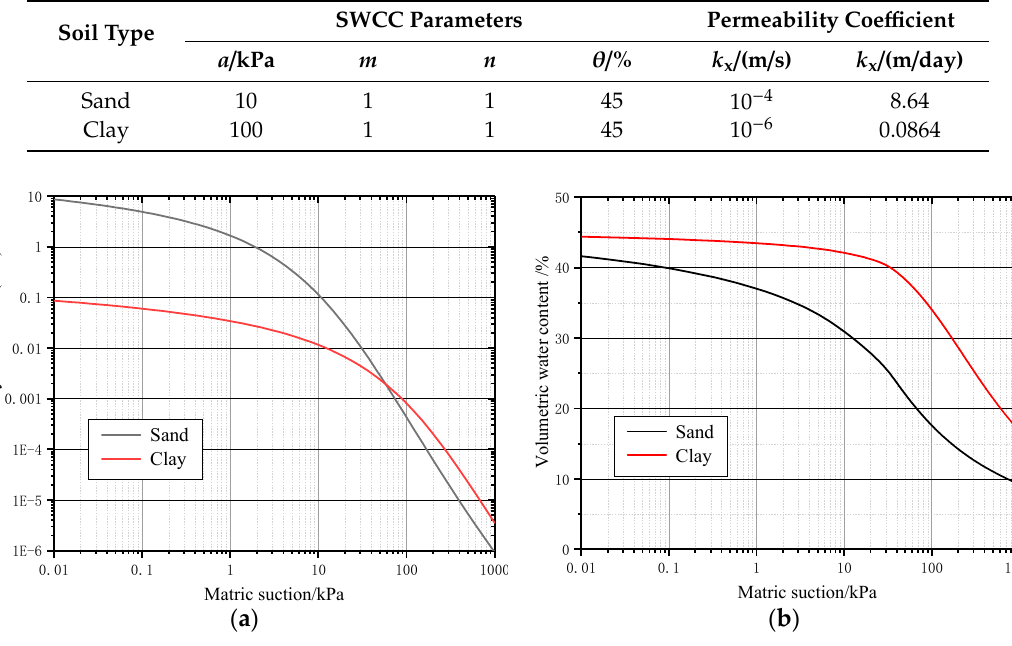
Figure 2. Typical appearance of sandy and clayey soil. ( a ) Clayey soil. ( b ) Sandy soil. Table 1. Unsaturated parameter values. Table 1. Unsaturated parameter values.